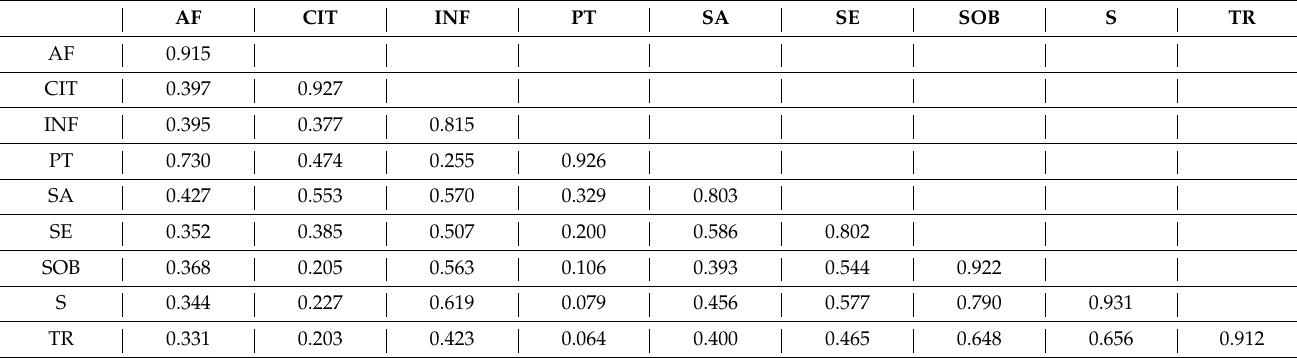
Table 5. Discriminant Validity